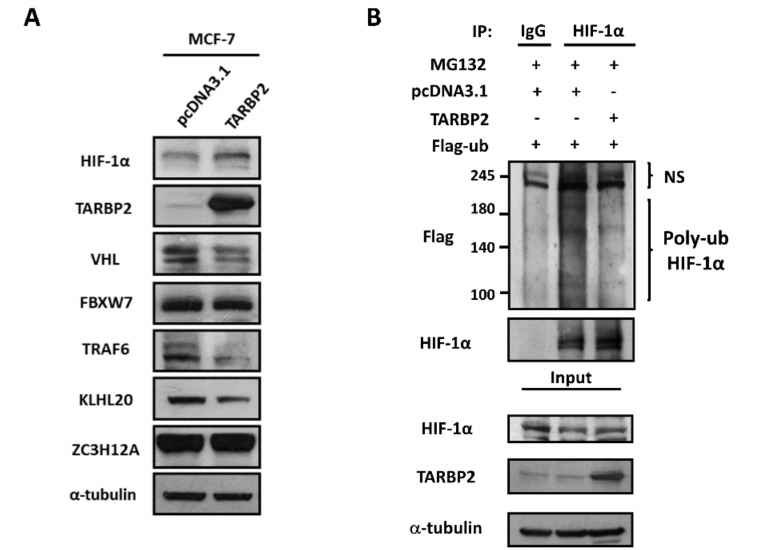
Figure 5. TARBP2 downregulates multiple E3 ligases and HIF-1 α ubiquitination. ( A ) Protein expres- sion of HIF-1 α , VHL, FBXW7, TRAF6, KLHL20, and ZC3H12A in TARBP2-overexpressing MCF-7 cells. ( B ) Ubiquitination of HIF-1 α in TARBP2-overexpressing MCF-7 cells. TARBP2-overexpressing MCF-7 cells were treated with MG132 for 24 h and subjected to